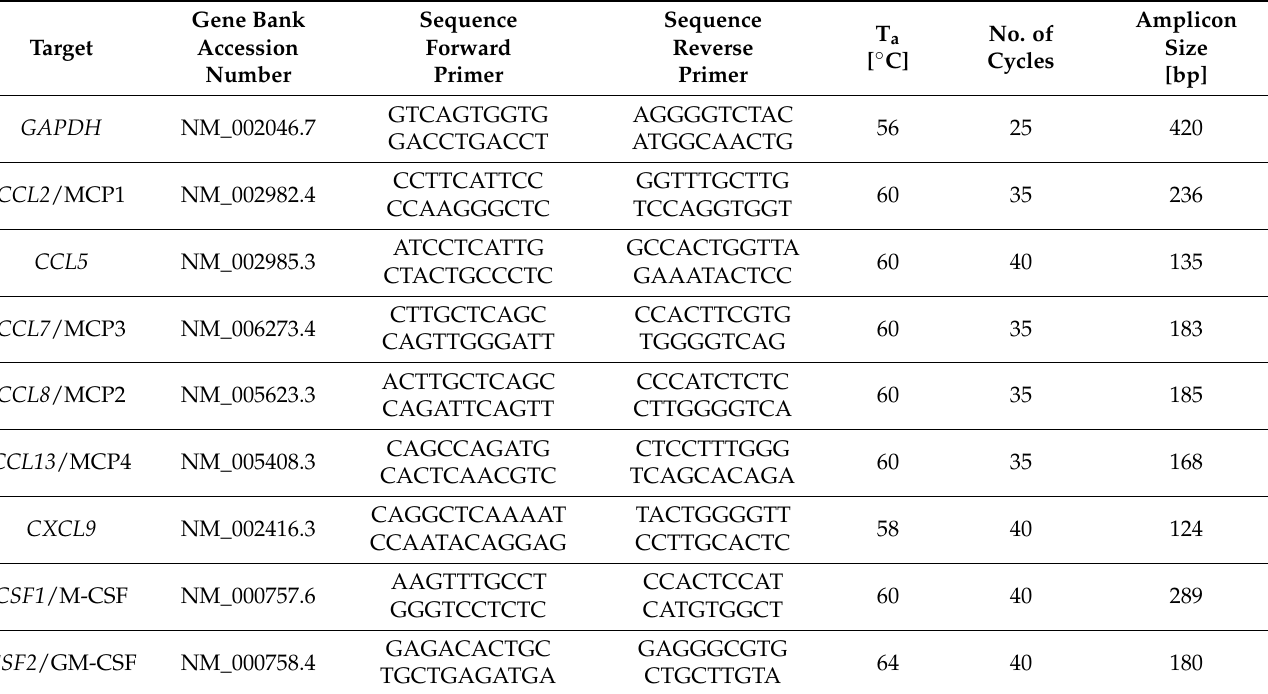
Table 1. List of primers, their sequences, and the corresponding PCR